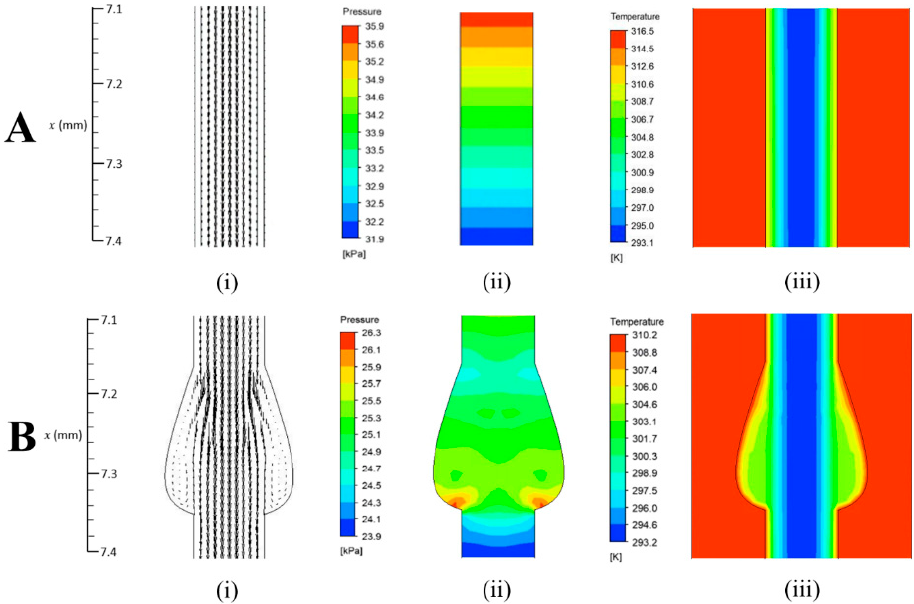
Figure 4. ( i ) velocity vectors, ( ii ) pressure contour and ( iii ) temperature contour for ( A ) conven ‐ tional MCHS, and ( B ) CMCHS with β = 0.5, γ = 1.8 and δ = 0.75. MCHS, and ( B ) CMCHS with β = 0.5, γ = 1.8 and δ = 0.75.